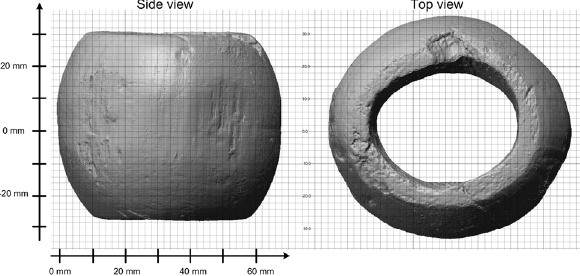
Figure 7. 3D model of a wooden element.